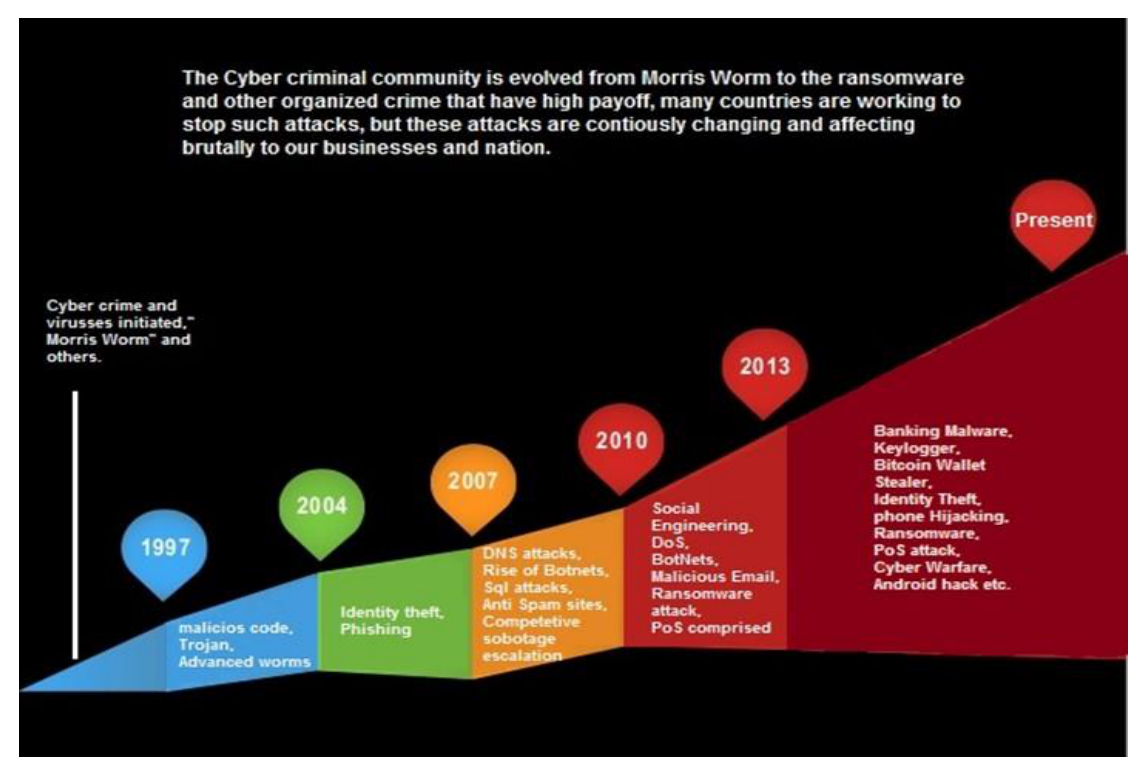
Figure 32. The advancements in cyber attacks over time [115]. Abbreviations used: DNS, Domain Name System; SQL, Structured Query Language; DOS, Denial of Service; Botnet, Bot Network; and POS, Point-of-Sale.